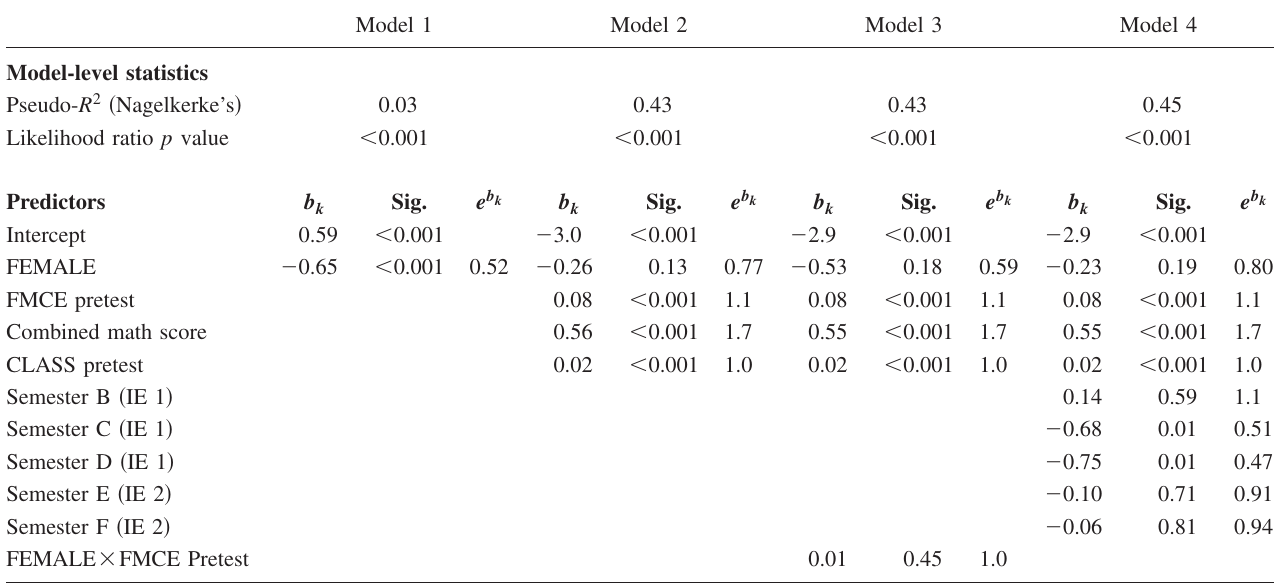
TABLE X. Logistic regression analysis results. In each model covariates are included to control for differences in student background. Gender is not significant in the final